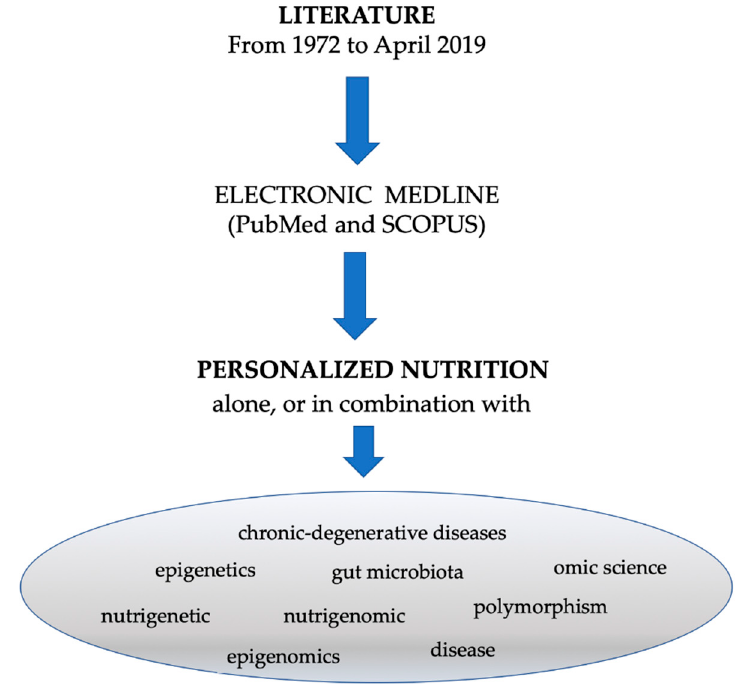
Figure 2. Flow diagram of search strategy.